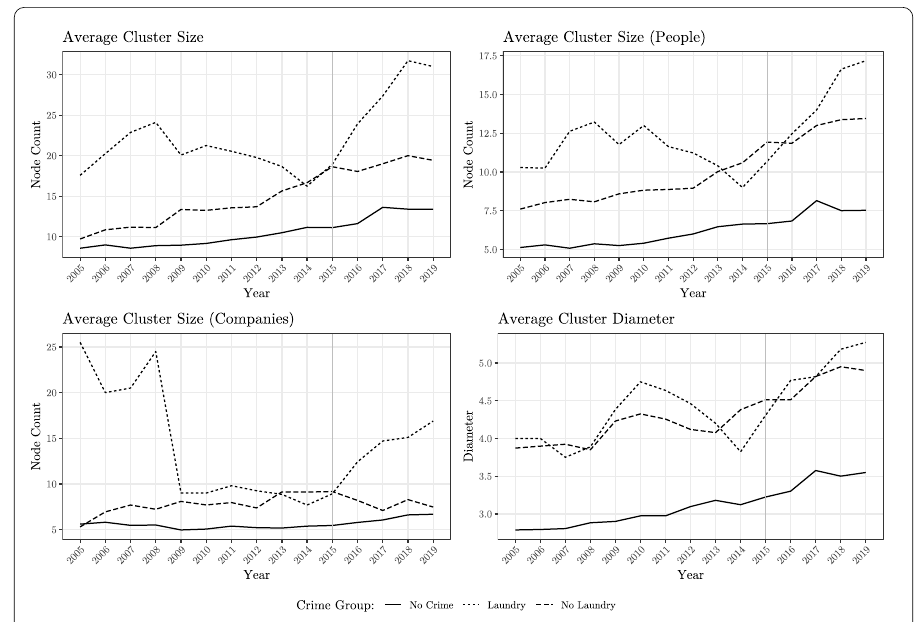
Figure 4 Cluster measures of size. This figure shows 4 line charts that show the development for each cluster type on average cluster size, average cluster size (people), average cluster size (companies) and the average cluster diameter